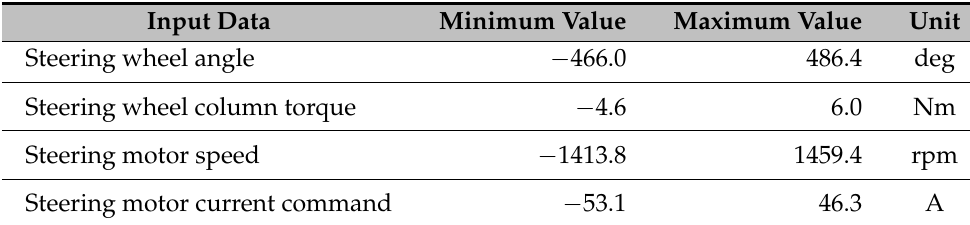
Table 2. Input data of a deep learning model.